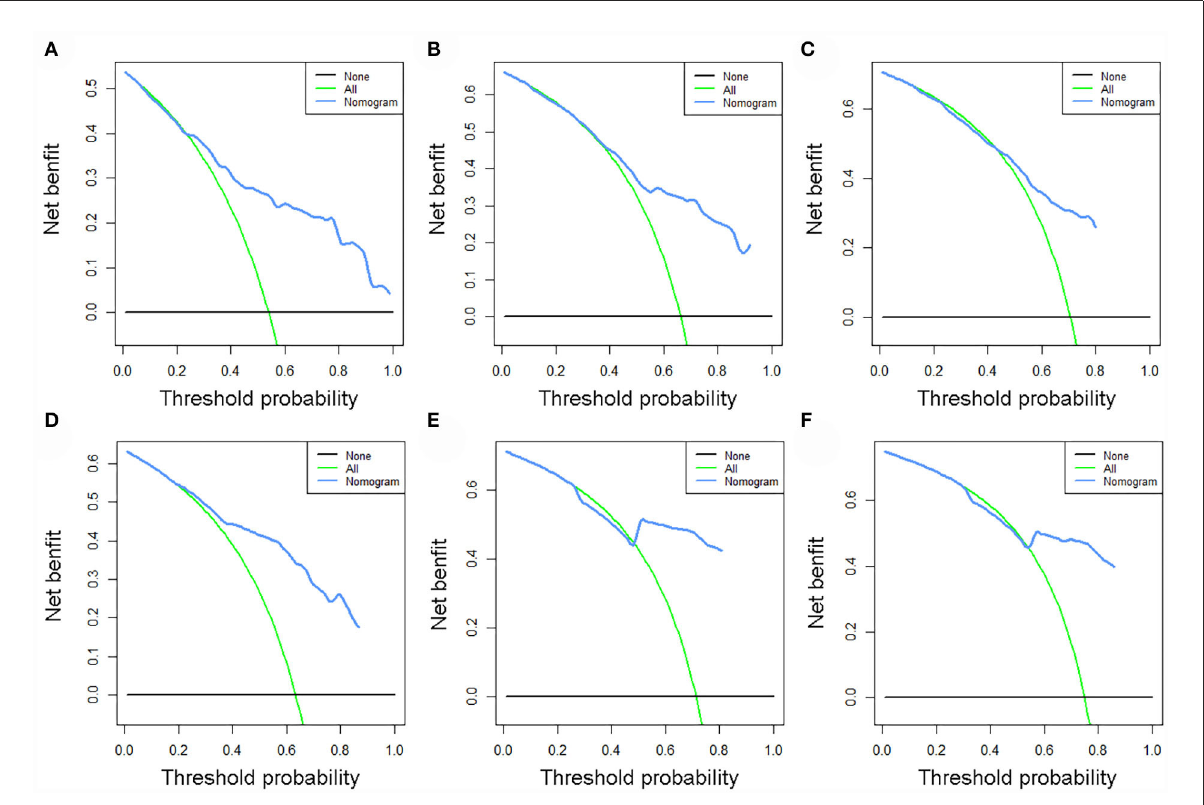
FIGURE11 DCA curves of 24- (A) , 36- (B) , and 48-month (C) OS in the training set and 24- (D) , 36- (E) , and 48-month (F) OS in the validation set.